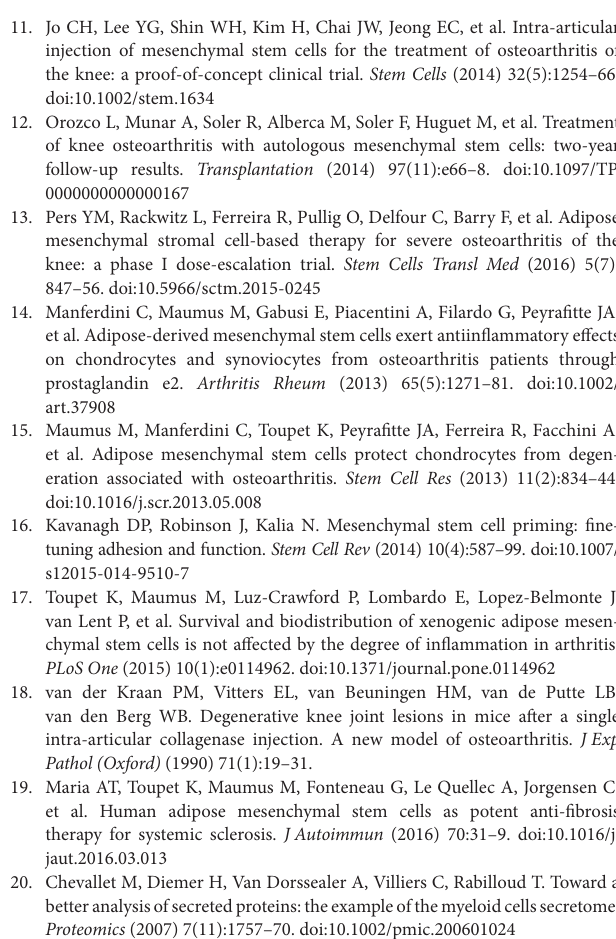
FigUre s1 | Validation of secretome analysis. (a) Gene expression of proteins identified in the secretome of chondrocyte/ASC cocultures. Data represent the relative gene expression (2 −Δ CT ) in ASC monoculture (white bars), in chondrocyte monoculture (black bar), and in chondrocyte/ASC cocultures (gray bar). Results are represented as mean ± SEM ( n = 3 biological replicates). Abbreviations: PYCARD , PYD and CARD domain containing; CSTA , cystatin A; SRGN , serglycin; XYLT1 , xylosyltransferase 1; THBS1 , thrombospondin-1; PTX3 , pentraxin-3; EDIL3 , EGF-like repeats and discoidin domains 3; UCHL3 , ubiquitin C-terminal hydrolase L3; IGFBP5 , insulin-like growth factor binding protein 5; COL4A2 , collagen type IV alpha 2; NDRG1 , N-Myc downstream regulated 1; ARG1 , arginase 1. (b) SRGN, THBS1, PTX3, UCHL3, and NDRG1 mRNA level was measured in chondrocytes and in ASCs cultured alone or in cocultures (co) by RT-qPCR. Results are expressed as relative gene expression (2 −Δ CT ) and represented as mean ± SEM ( n = 5 biological replicates). Statistics used Mann–Whitney test: *p ≤